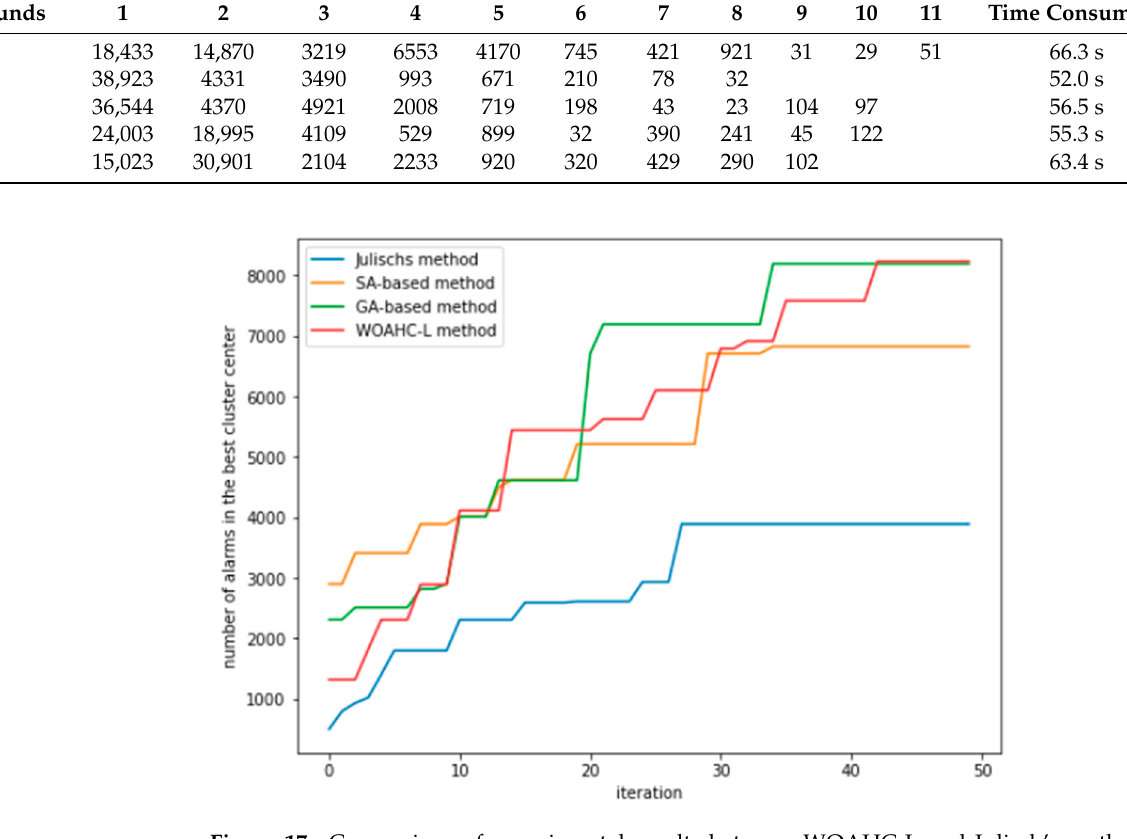
Figure 17. Comparison of experimental results between WOAHC-L and Julisch’s method, SA and GA .